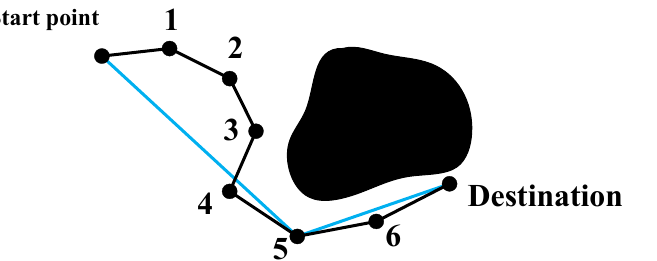
Figure 10. Contract a feasible